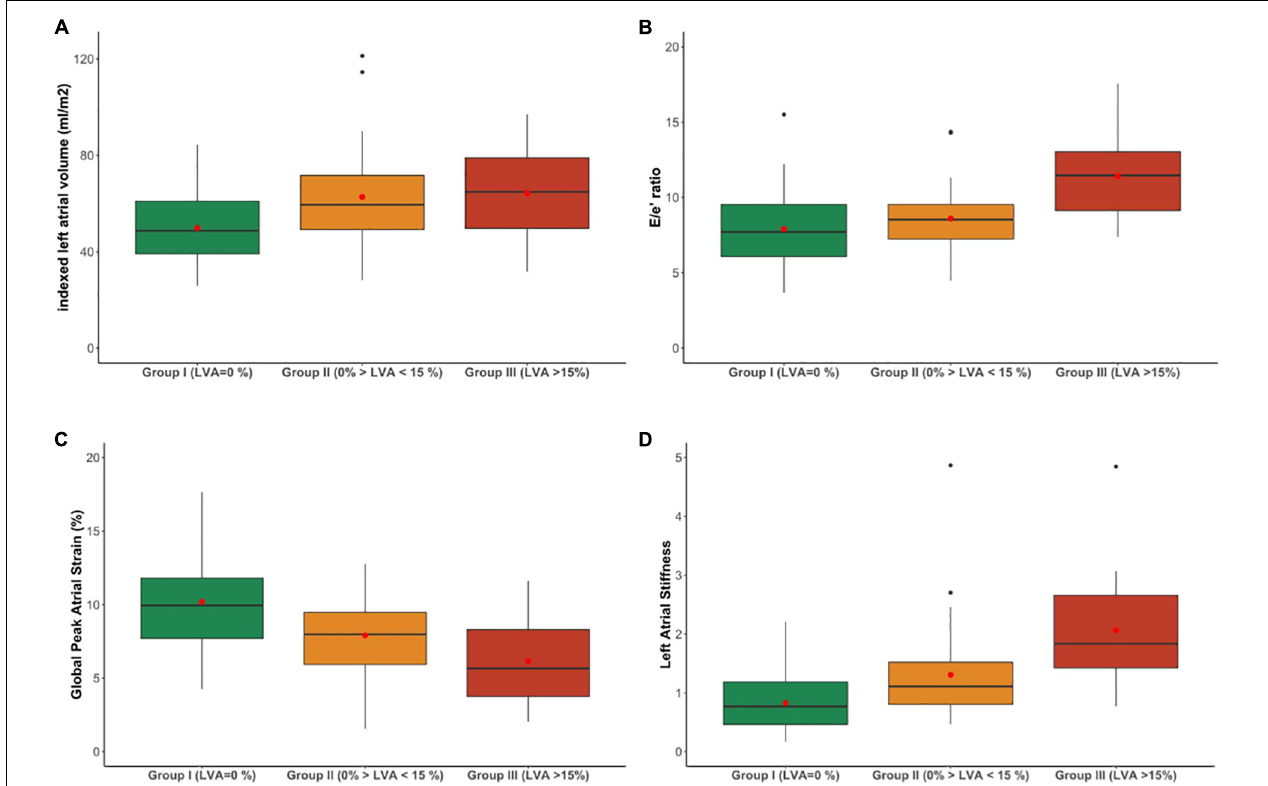
FIGURE 2 | Indexed left atrial volume (A) , E/e (cid:48) ratio (B) , Global Peak Atrial Longitudinal Strain (GPALS) (C) , and left atrial stiffness (D) in patients with permanent AF according to their stages of low-voltage area extent. The box represents interquartile range, the line indicates the median value, whiskers show minimum/maximum values, and the mean value is shown as a red dot and outliers as black dots.